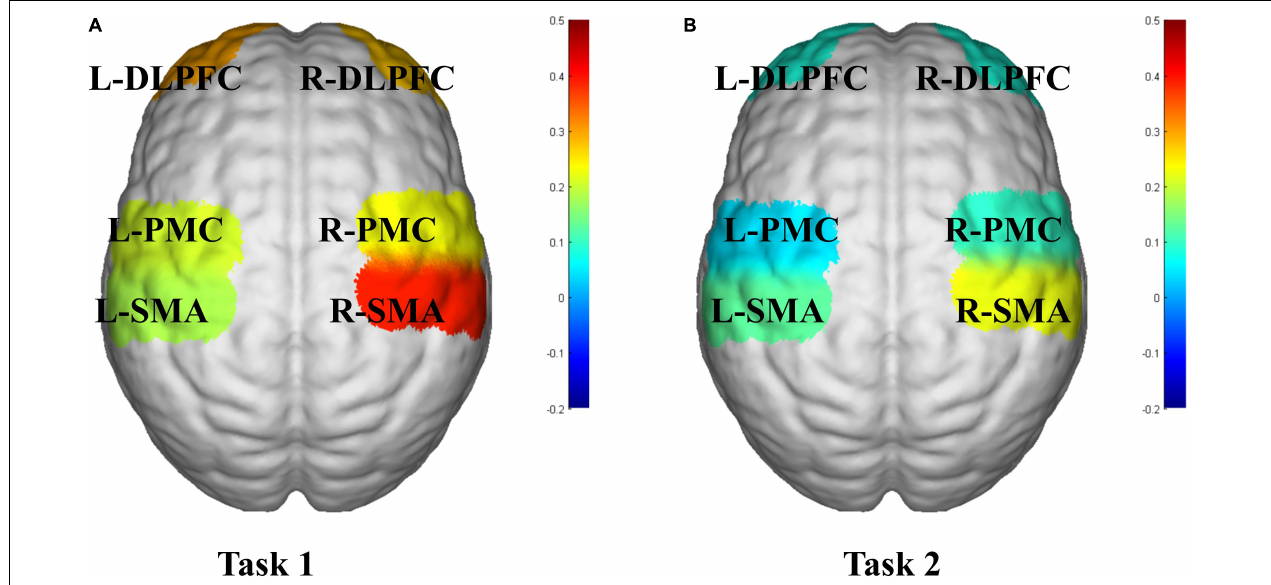
FIGURE 5 | fNIRS activation maps of two motor tasks. (A) Task 1, NIVR-Exergame task; (B) Task 2, resistance band stretching task. The beta values are indicated by color. SMA, supplementary motor cortex; PMC, premotor cortex; DLPFC, dorsolateral prefrontal cortex; L, left; R, right.